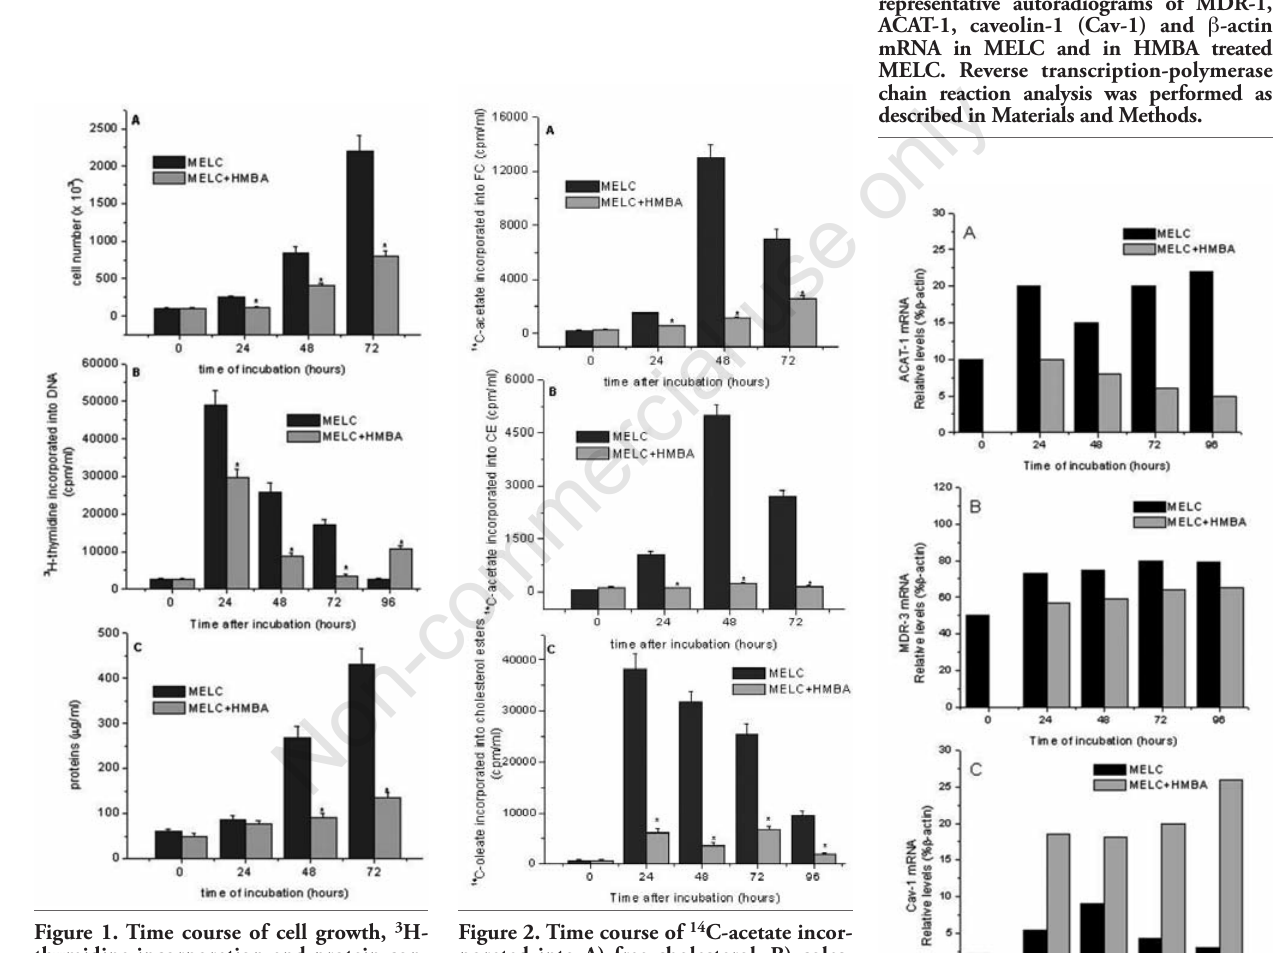
Figure 1. Time course of cell growth, 3 H- thymidine incorporation and protein con- tent in murine erythroleukemia cells (MELC) in presence or absence of hexam- ethylene bisacetamide (HMBA). MELC cells were seeded at a density of 1 ¥ 10 5 cells/mL and stimulated to growth by adding 10% FCS. At the indicated times A) cell number, B) 3 H-thymidine incorpora- tion and C) protein content were deter- mined as described in Materials and Methods. Data are mean±Standard Error of three independent experiments, each per- formed in triplicate. *Indicates statistically significant (P<0.05) compared with MELC.